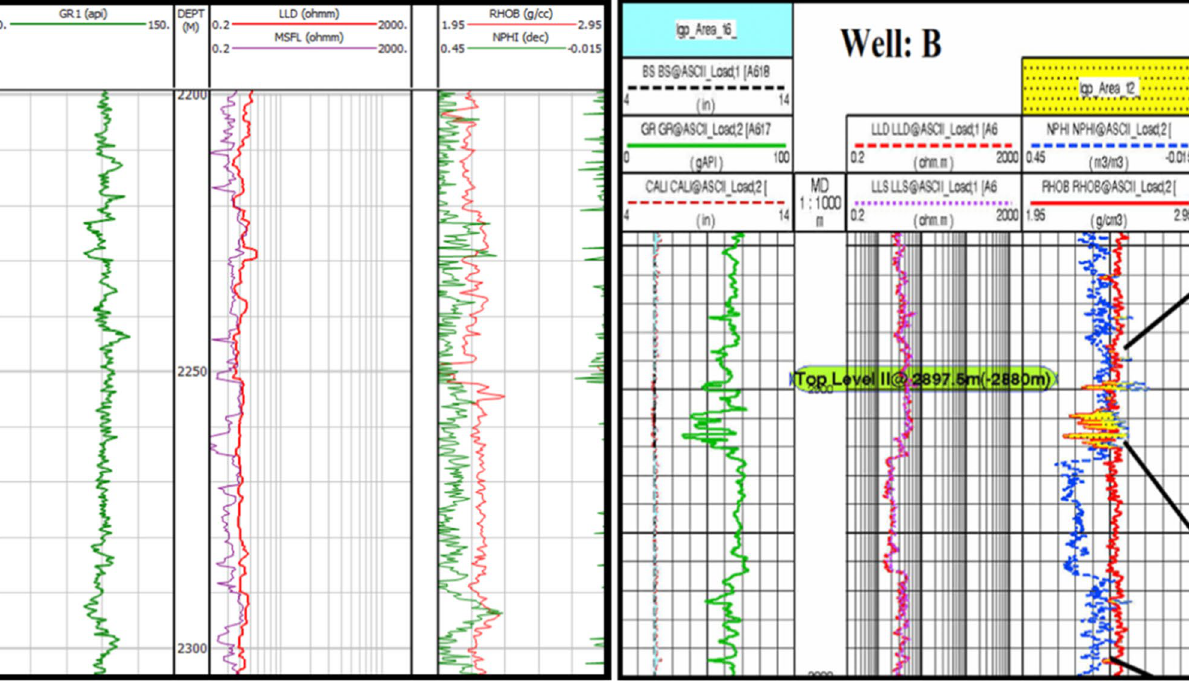
pay varies between 2 and 3 Ω, where the resistivity of the Well_1 var- ies between 0.5 and 0.6